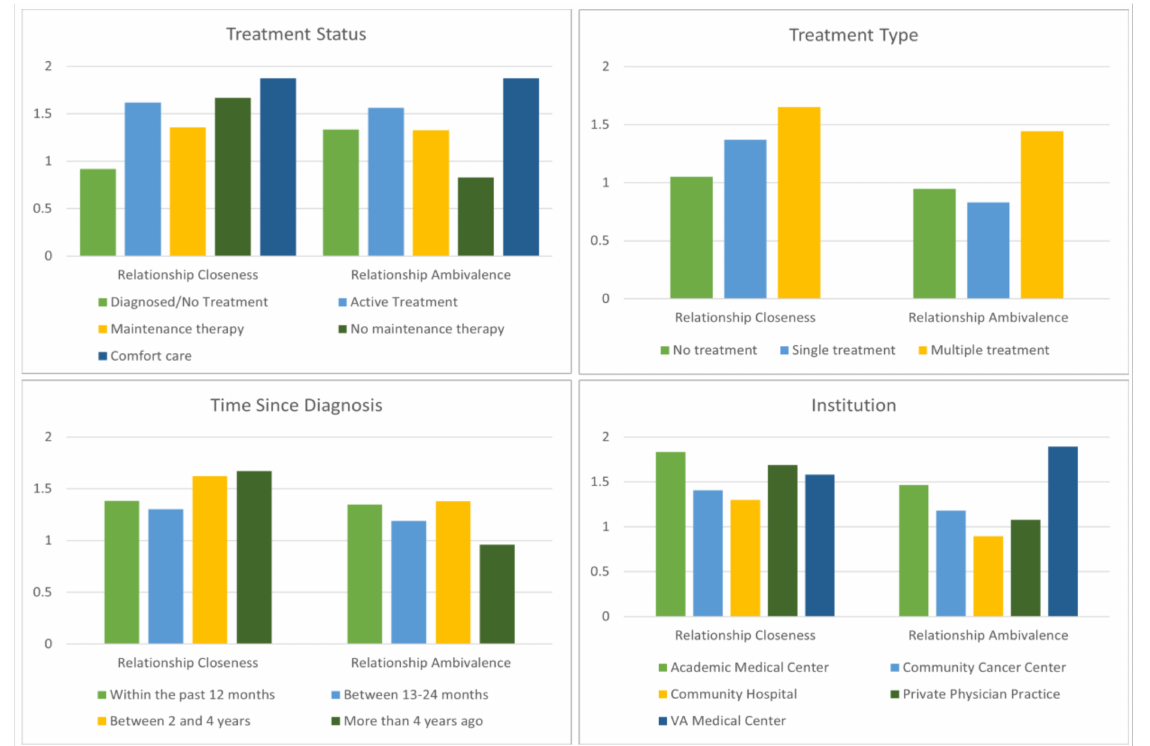
Figure 2. Mean scores for relationship closeness and ambivalence by key clinical